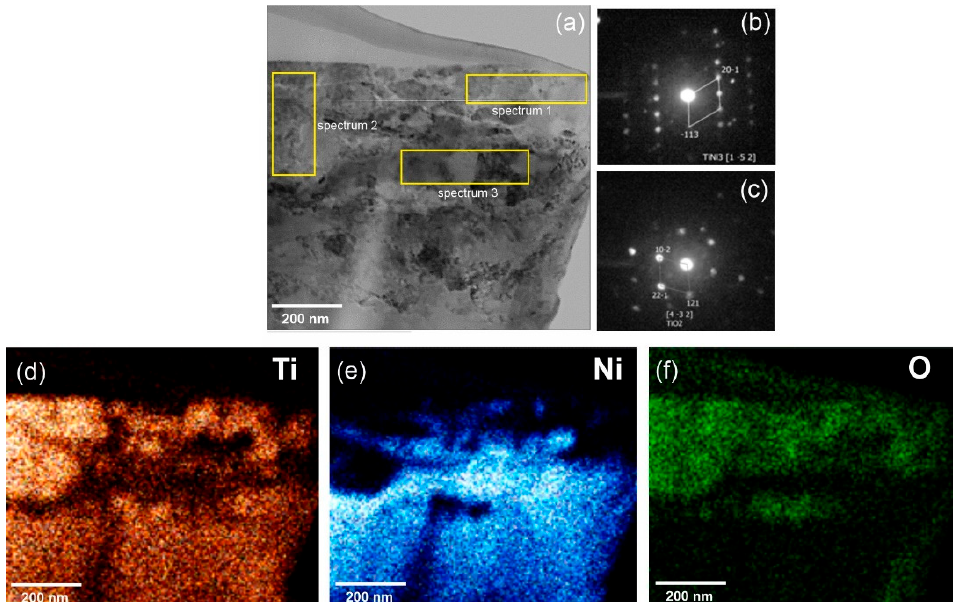
Figure 3. TEM image of a 60 µm wire section: ( a ) general view with selected areas for elemental analysis; ( b ) diffraction pattern of the selected area in spectrum 3; ( c ) diffraction pattern of the selected areas in spectra 1 and 2; ( d – f ) distribution maps of elements in the cross-section of the 60 µm thick NiTi wire.